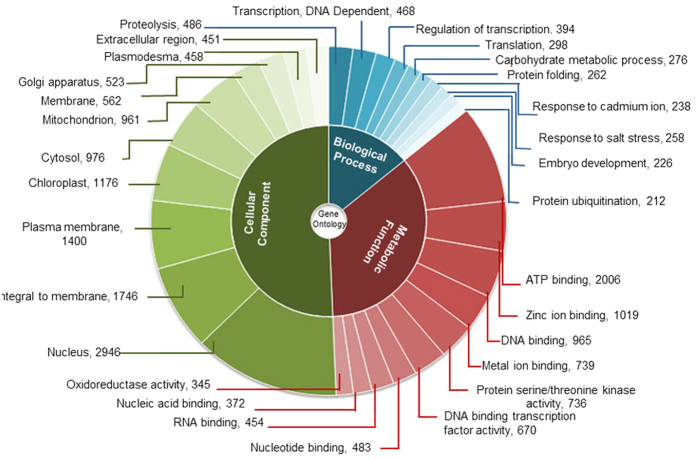
Gene ontology analysis of C. procera unigenes.The results are summarized in three main categories as Biological process, Molecular function and Cellular component. Slices show top ten most represented GO terms from each domain.